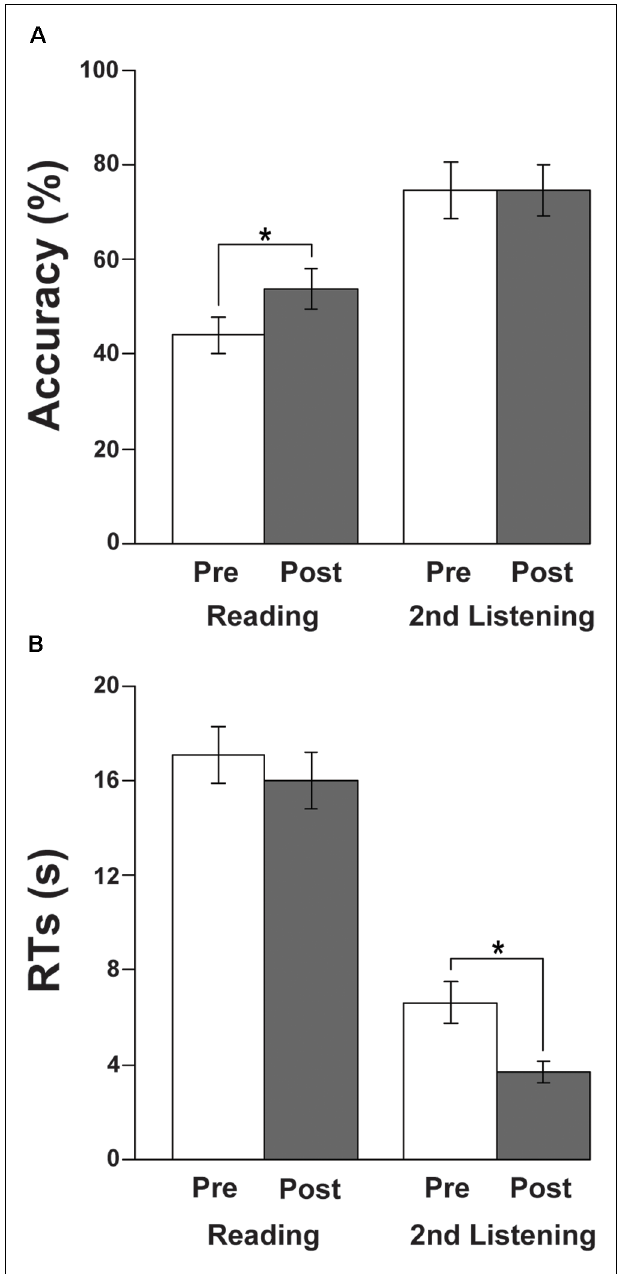
FIGURE 2 | Behavioral results. (A) Accuracy of the reading and listening tests. Note the significant improvement in the reading tests from Pre to Post sets during the course of learning Japanese. (B) Response times (RTs) of the reading and listening tests. Note the significant improvement (i.e., reduction in RTs) in the listening tests from Pre to Post. The error bars denote the SEM (standard error of the mean). * p < 0.05 (paired t -test).